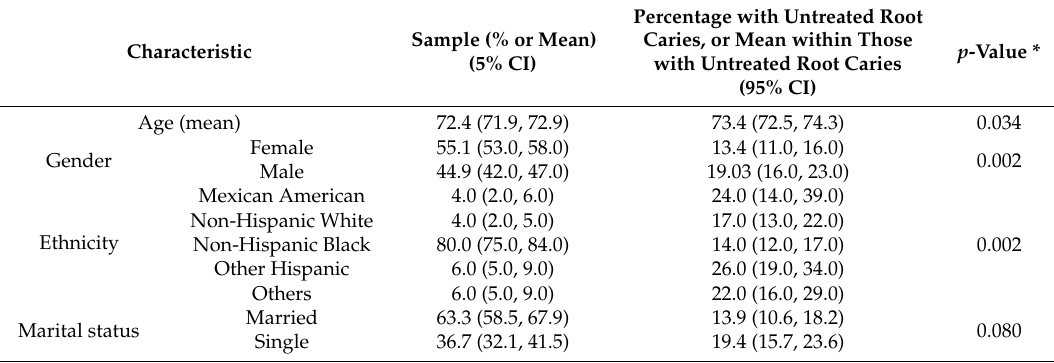
Table 1. Distribution of all variables included in the analysis and percentage of untreated root caries, in older American adults aged 65 + , National Health and Nutrition Examination Survey (NHANES) 2015–2018, ( n =